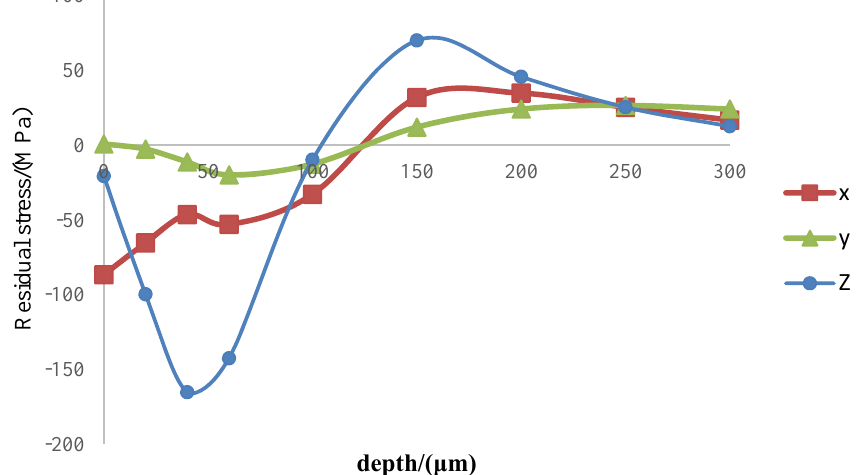
Figure 14. Residual stress (scratching length = 5 mm).